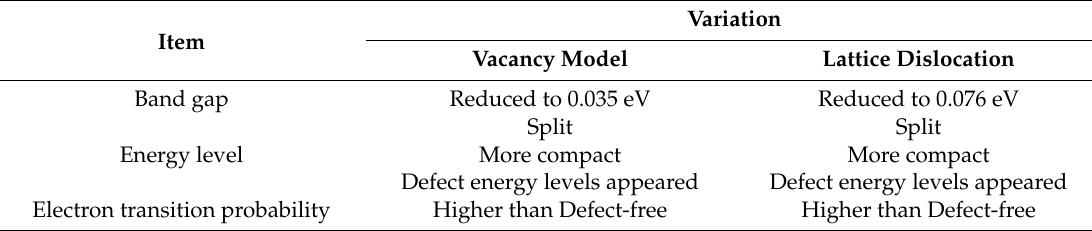
Table 2. Band structure of vacancy model and lattice dislocation.